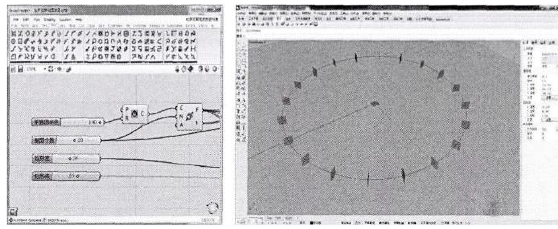
Figure 4: The first stage of modeling